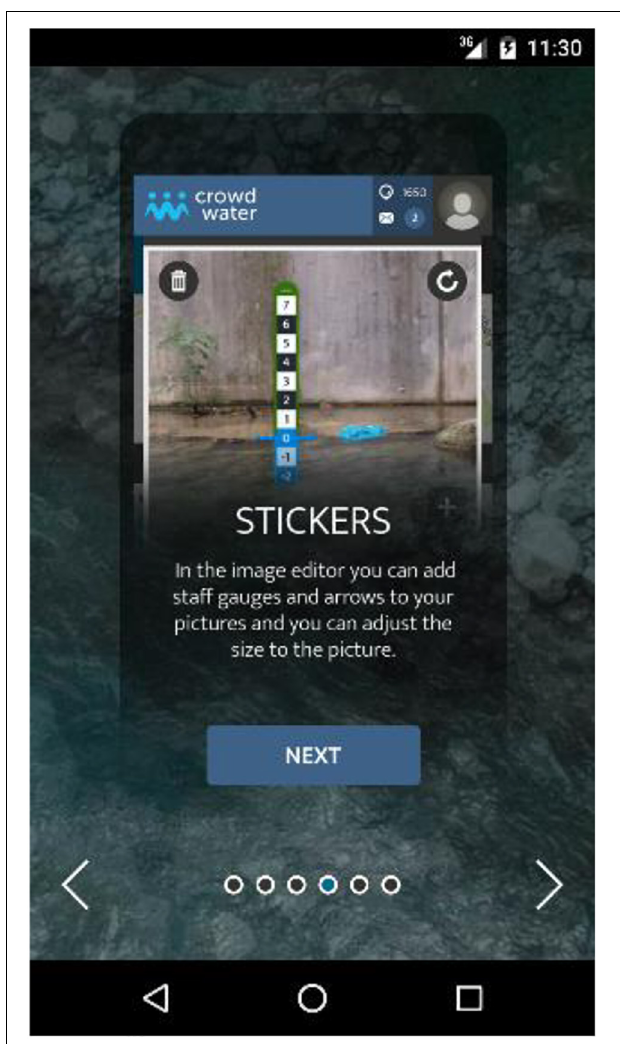
FIGURE 9 | Screenshot of an intro slide that appears when the app is opened for the first time. These can be re-watched anytime. The goal is to quickly provide the most important information on the basic functionalities of the app.